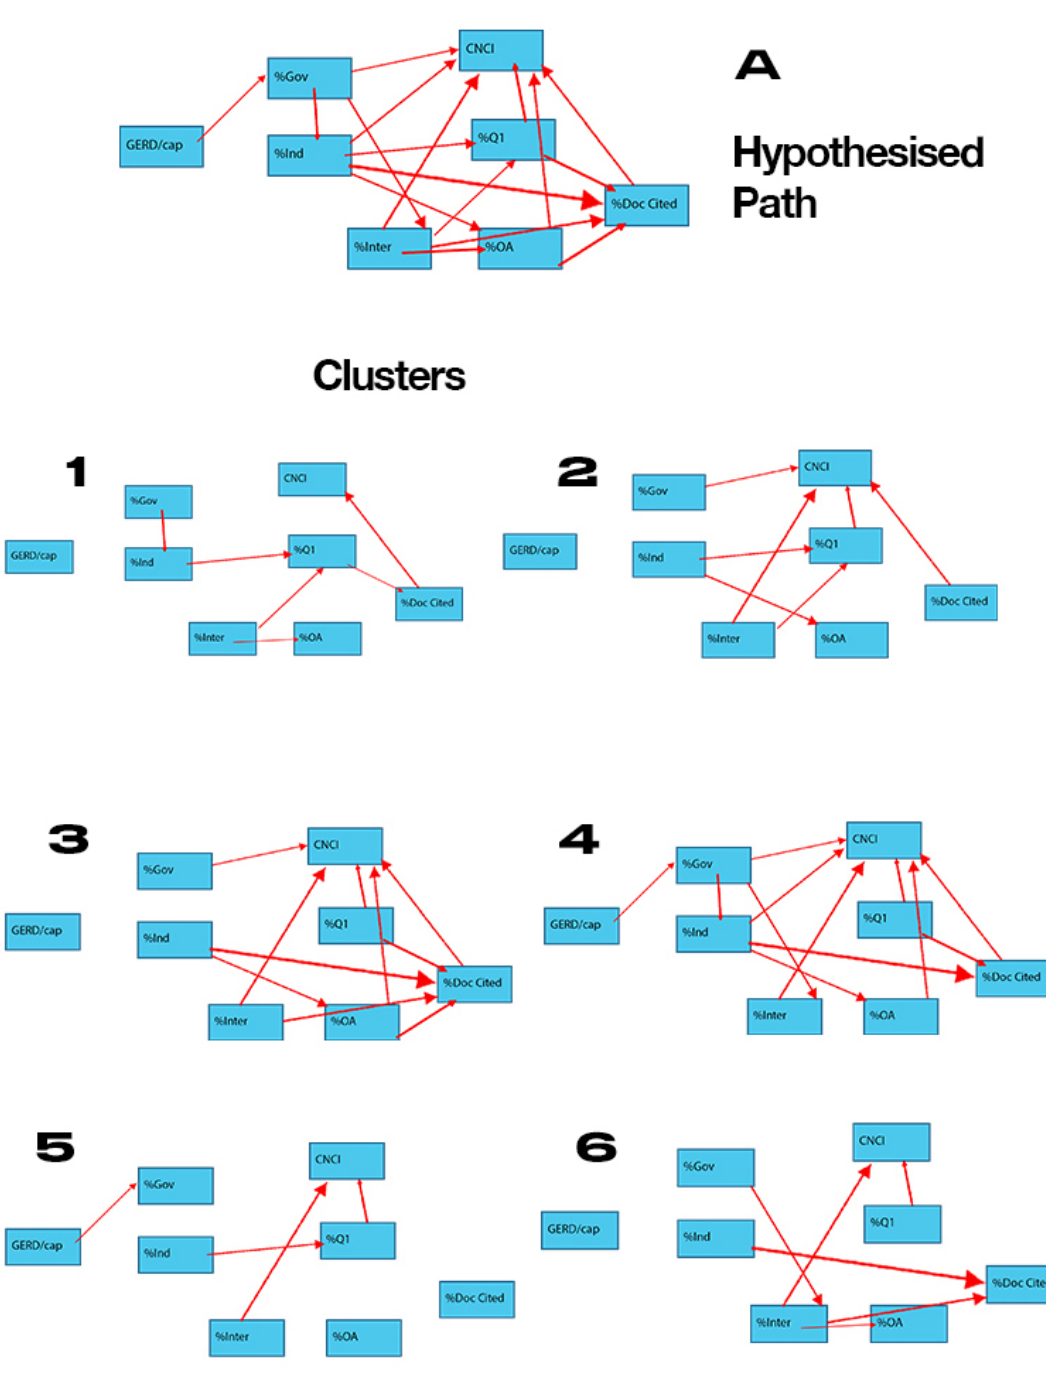
Figure 4. Hypothesised path diagram for within clusters (a) and significant paths by cluster (1 – 6) (See Figure 1 for countries within each cluster and abbreviations are in